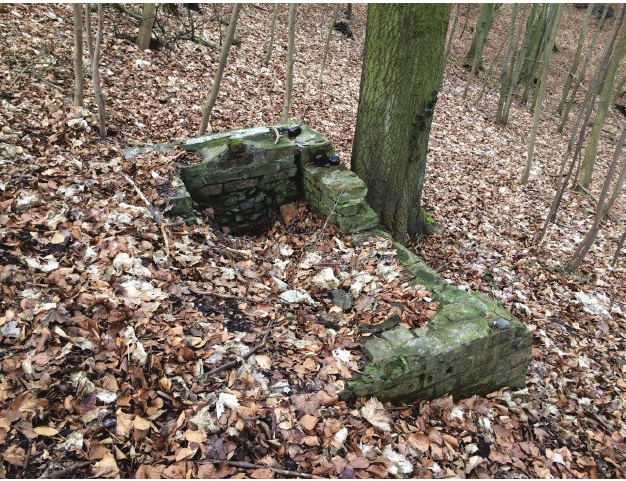
Figure 9: Jewish cemetery listed in the register of historical monuments. Photo: K. Puzdrakiewicz.